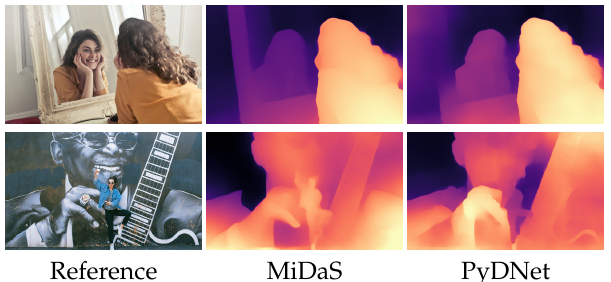
Figure 5. Failure cases. Examples of failure cases of single image depth estimation. From left to right: input image, depth predicted by the teacher and depth predicted by the